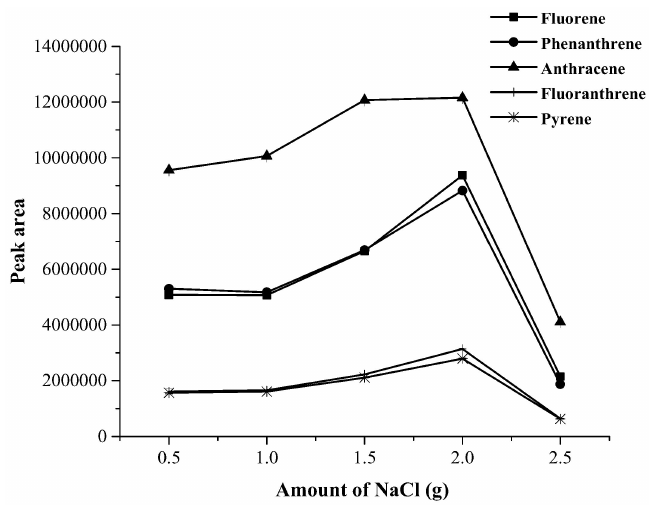
Figure 2. Effect of NaCl amount on the extraction